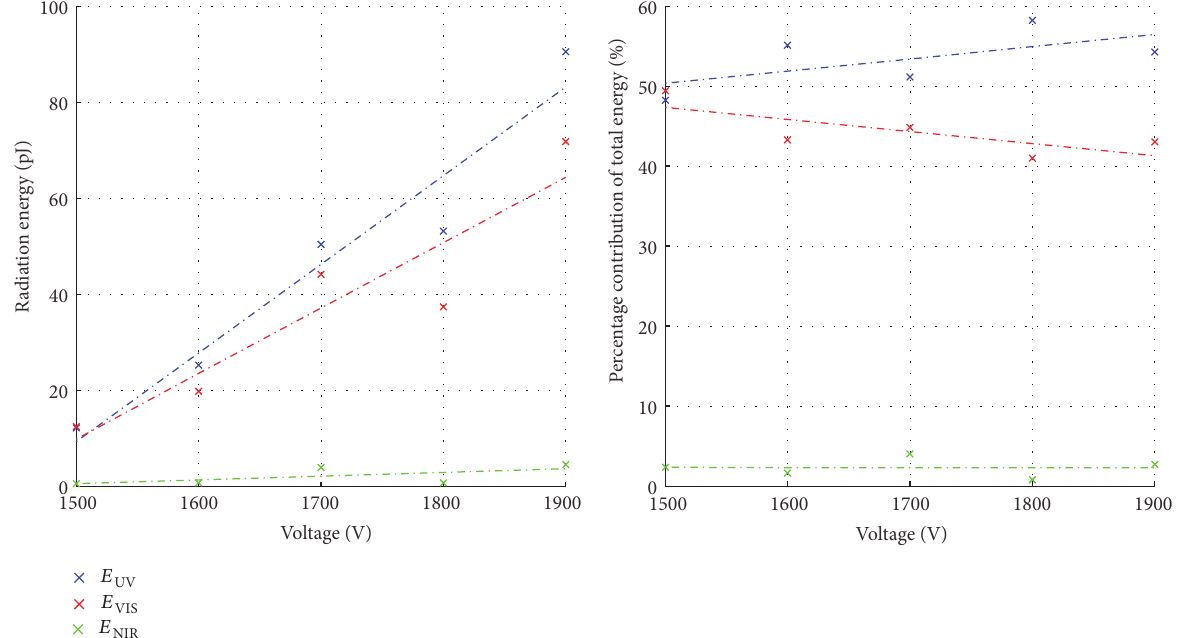
Figure 9: Dependency of voltage on the calculated electromagnetic radiation energy